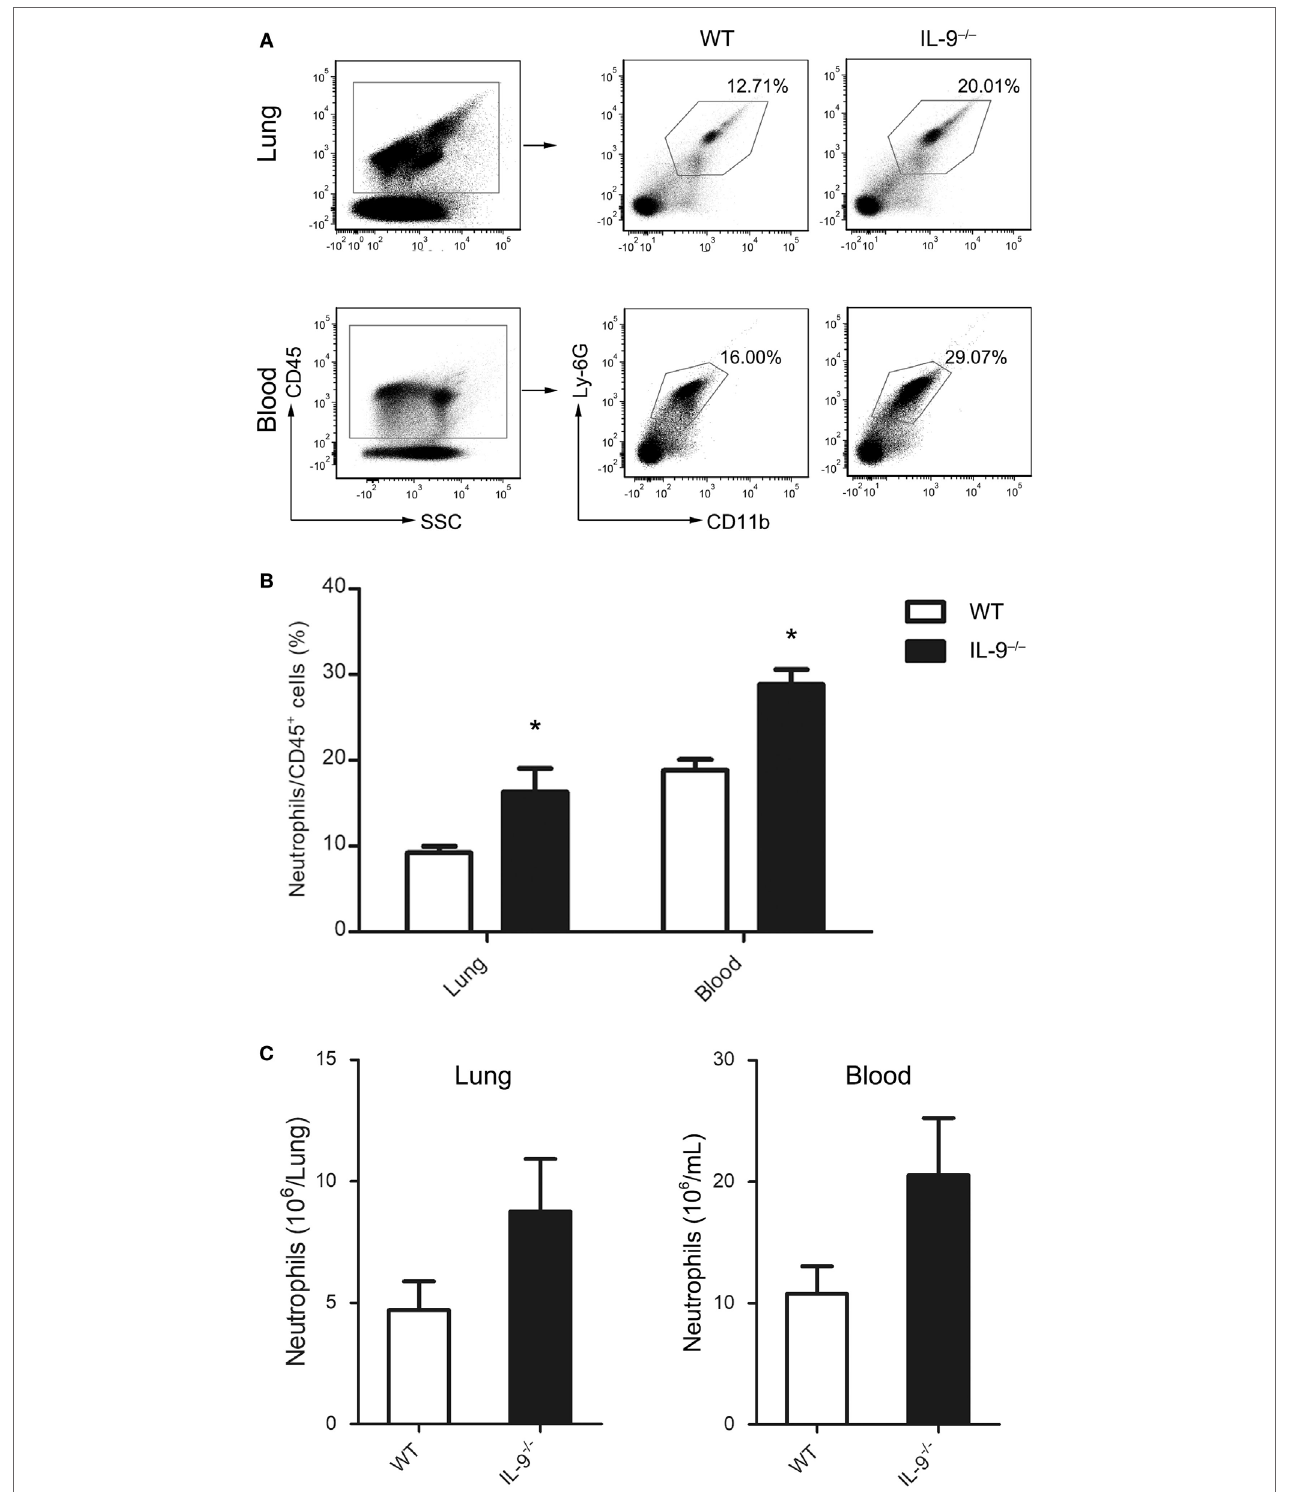
FigUre 7 | IL-9 ‒ / ‒ mice recruited more neutrophils during Pneumocystis infection. Neutrophils from blood and lung were determined by flow cytometry in WT and IL-9 ‒ / ‒ mice at 3-week after Pneumocystis infection. (a) The percentage of neutrophils (CD45 + CD11b + Ly-6G + ) in all CD45 + cells were shown in the representative flow cytometric dot plots of three independent experiments. The percentage (B) and absolute numbers (c) were higher in IL-9 ‒ / ‒ mice than WT mice. Data are shown as mean ± SEM ( n = 4–5 per group). * P < 0.05 compared to WT group by Student’s t -test.